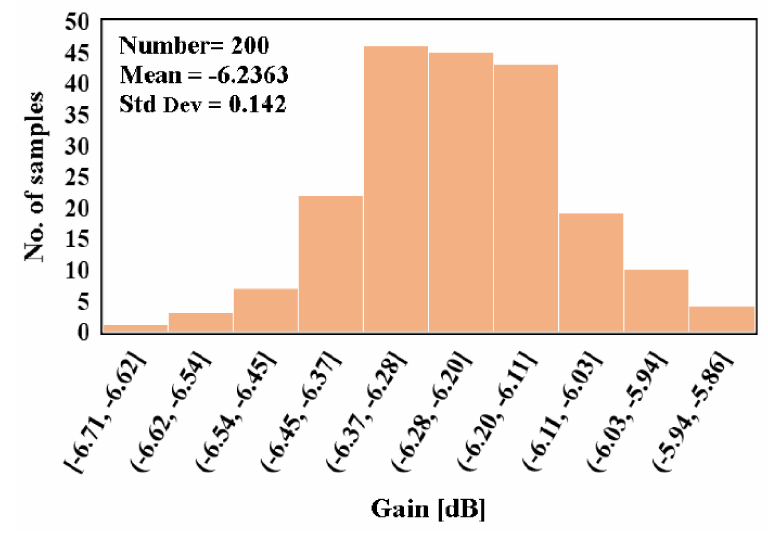
Figure 15. Monte Carlo simulation of the voltage gain.